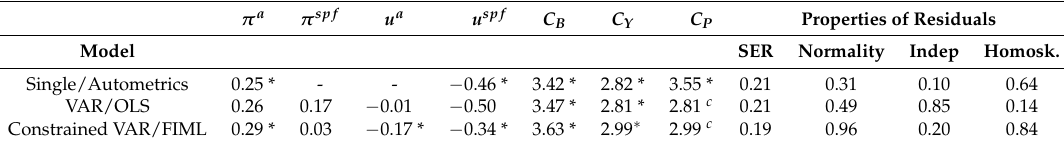
Table 3. Static Long-Run Solutions for the current-year projections for the federal funds rate by about 25 basis